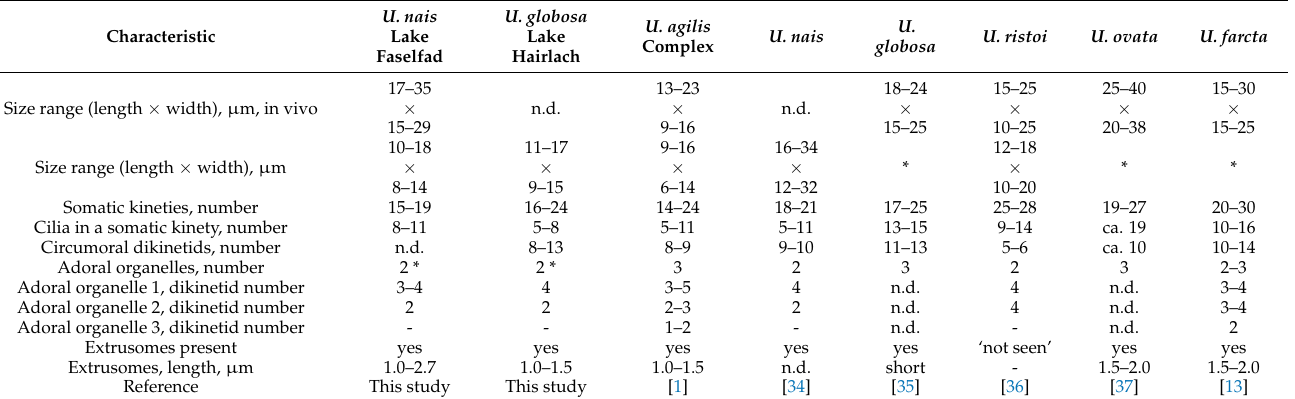
Table 2. Comparison of the main characteristics among the Urotricha strain CIL-2017/19 from Lake Faselfad, the natural Urotricha population from Lake Hairlach, the Urotricha agilis complex, Urotricha nais , Urotricha globosa , Urotricha ristoi , Urotricha ovata and Urotricha farcta based on stained material if not indicated otherwise. ‘n.d.’ not determined, ‘-’ not present, * observed only in very few specimens (n =